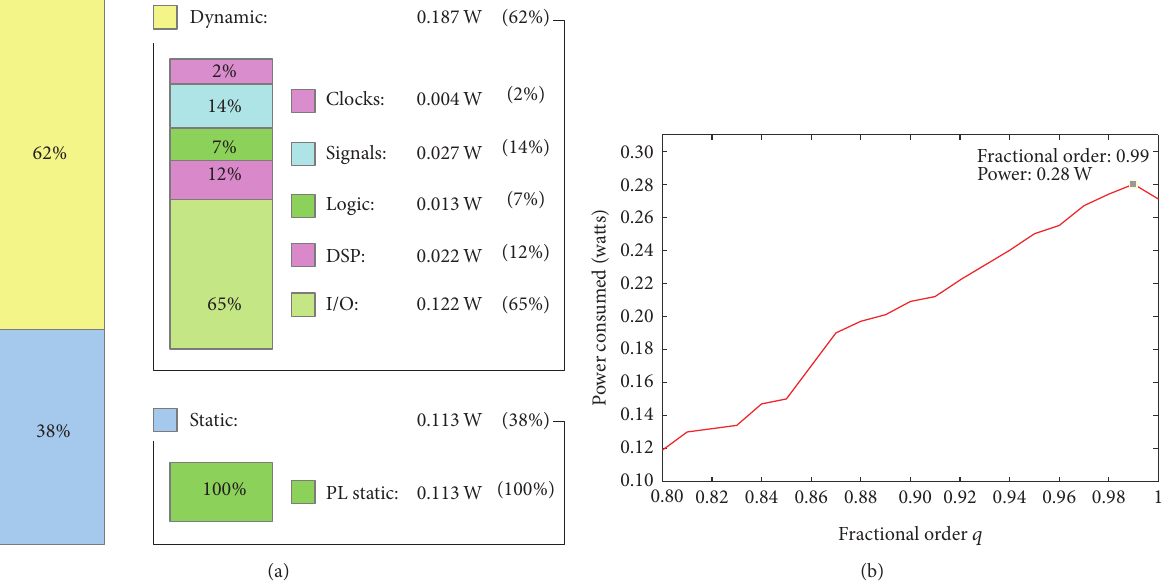
Figure 20: (a) Power utilized and (b) power utilization versus fractional order of FOMNE